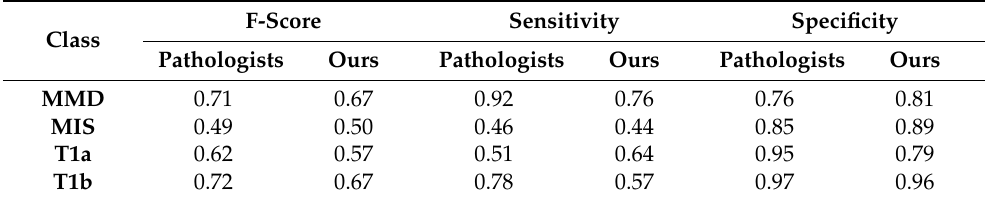
Table 6. Comparison of class-based F-score, sensitivity, and specificity of 187 US pathologists and our best model (WSI + EPN + DMN-M) on the same testing set.